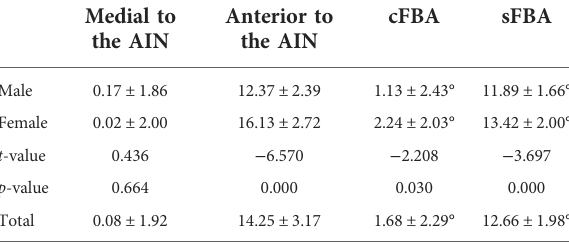
TABLE 2 Data analysis comparison between males and females. Medial to Anterior to cFBA the AIN the AIN